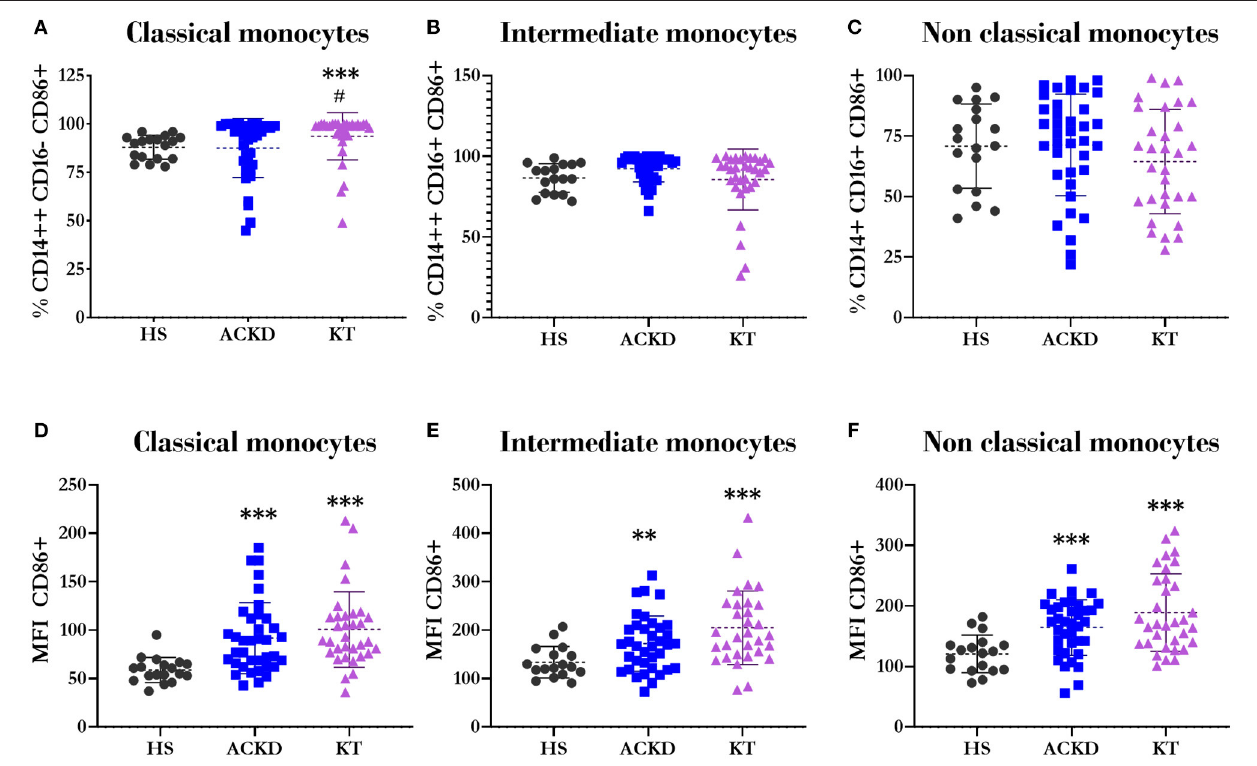
FIGURE 6 | Expression of CD86/B7.2 in different monocyte subsets. Percentage of classical Φ (A) (CD14 ++ CD16–), intermediate Ω (B) (CD14 ++ CD16 + ), and non-classical Ψ (C) (CD14 + CD16 + ) monocytes expressing CD86. Mean fluorescence intensity of CD86 in classical Ω (D) (CD14 ++ CD16–), intermediate Ω (E) (CD14 ++ CD16 + ), and non-classical Ω (F) (CD14 + CD16 + ) monocytes in healthy subjects (HS), patients with advanced chronic kidney disease (ACKD), and patients with kidney transplantation (KT). ** p ≤ 0.01, *** p ≤ 0.001 vs. HS; # p ≤ 0.05 vs. ACKD. Statistical analysis: Ψ ANOVA (Tukey test). Ω ANOVA (Games–Howell test). Φ Mann–Whitney U- test. ANOVA, analysis of